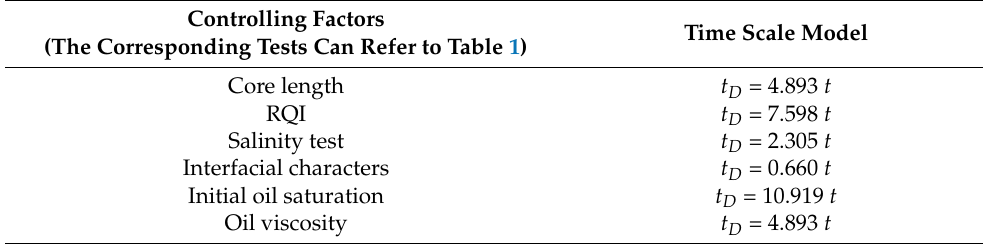
Table 4. The dimensionless time equation for each controlling factor.